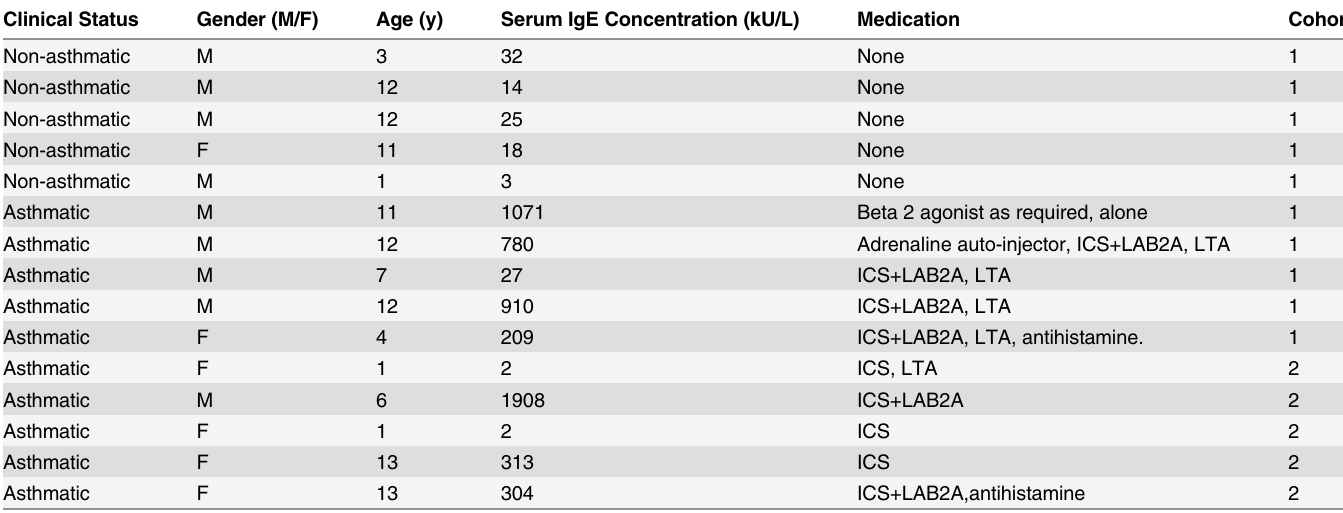
Table 1. Clinical Details of